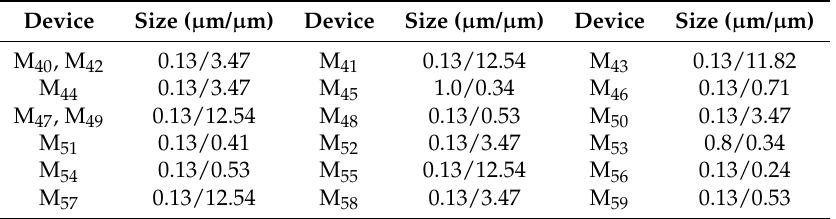
Figure A1. Bias circuit for the proposed work. Table A1. Transistors size of the bias